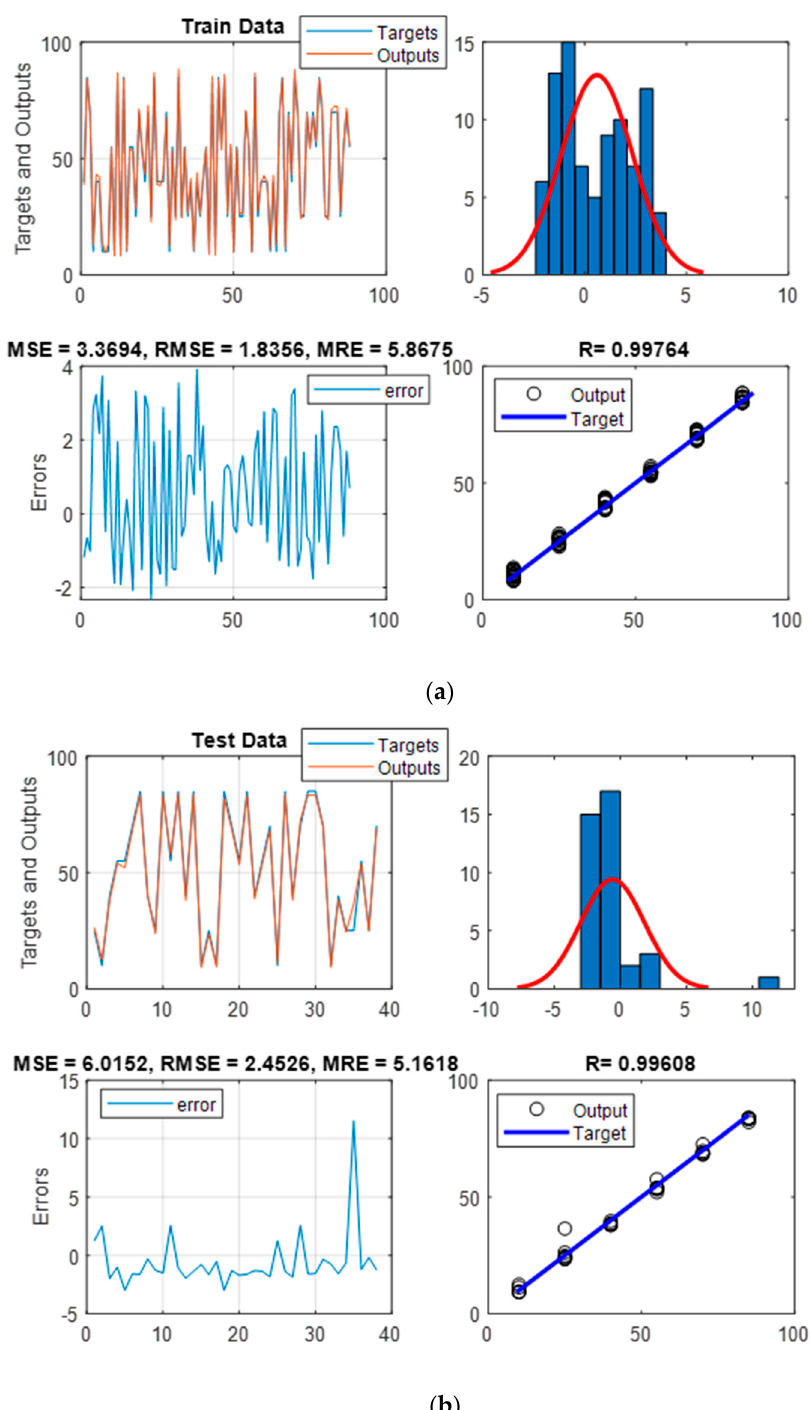
Figure 9. Performance of predictor network: ( a ) train and ( b ) test. Table 1. Specifications of the designed networks.